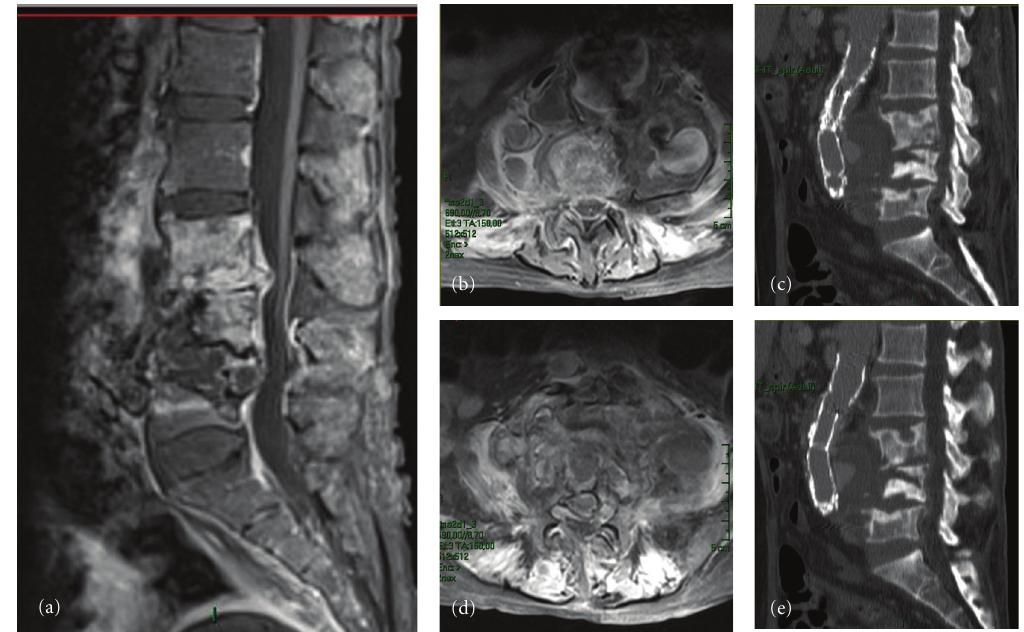
Figure 1: (a) Sagittal MRI, T1 showing the extension of the infectious process to three vertebral bodies L3-L4-L5 and to the intervertebral discs, as in a case of spondylodiscitis. ((b) and (d)) Axial MRI, T2 showing the paravertebral extension of the infection as well as an important compression of the sack and roots by the infection. ((c) and (d)) Sagittal CT showing the erosion and an extended rehashing of the bone as well as the involvement of the aortic prosthesis which has in part been pushed forwards by the infection. The CT also shows the integrity of the vertebral plain of the vertebrae adjacent to the damaged ones.